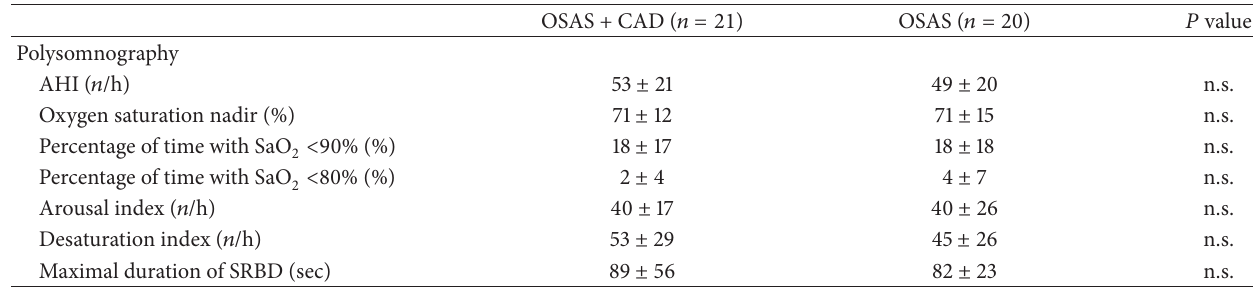
Table 2: Polysomnographic